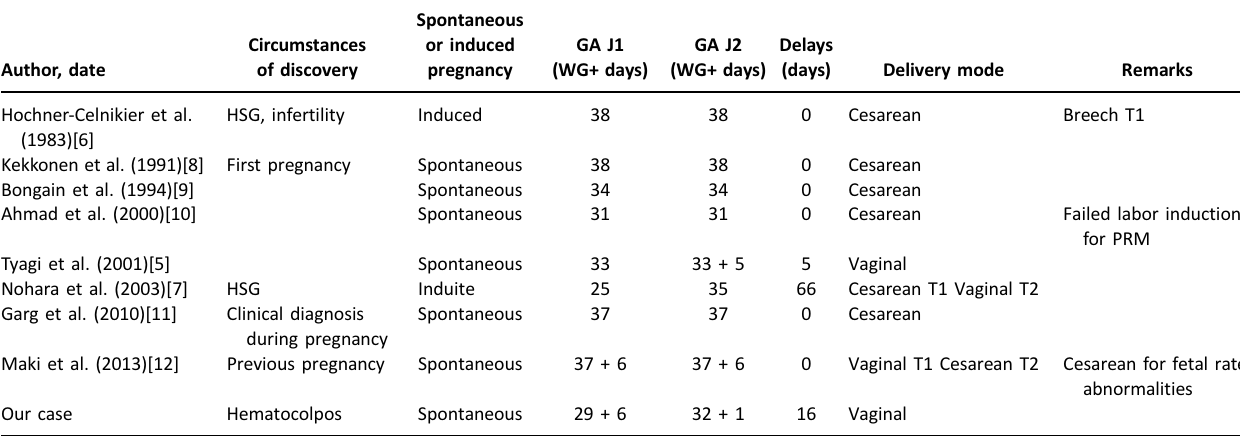
Table 1 . Literature review of simultaneous twin pregnancies in each cavity of a didelphys uterus with favorable